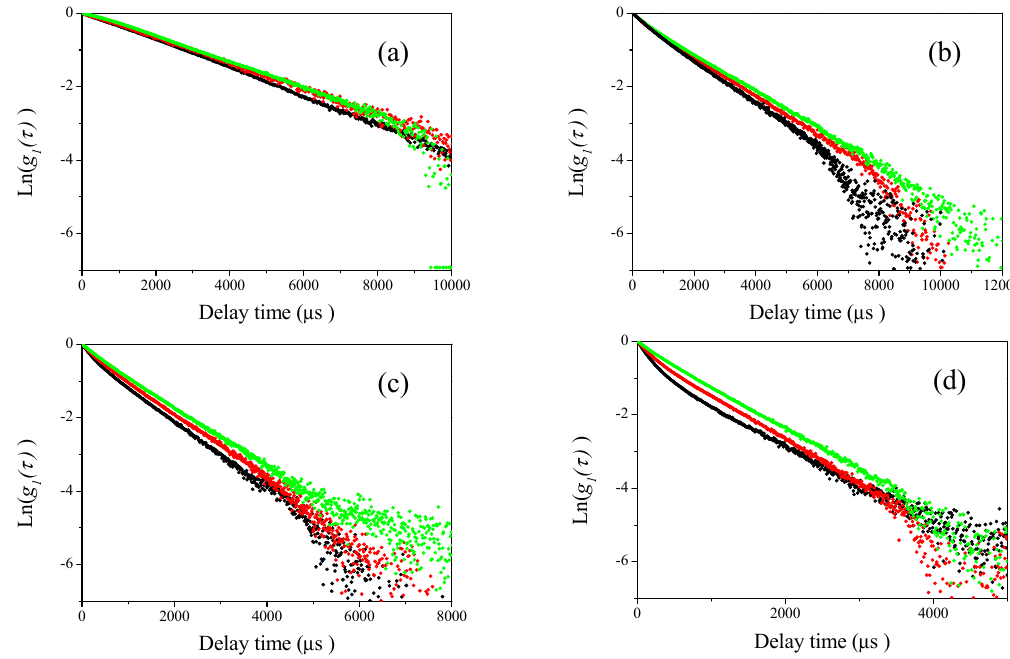
Figure 7. Example of observed homodyne photon correlation functions for polystyrene latex particles measured with DLS method (70-500-1 (black), 70-500-2 (red), and 70-500-3 (green)). ( a ) Light scattering was observed at a detector angle of 60°; ( b ) light scattering was observed at a detector angle of 90°; ( c ) light scattering was observed at a detector angle of 120°; and ( d ) light scattering was observed at a detector angle of 150°.